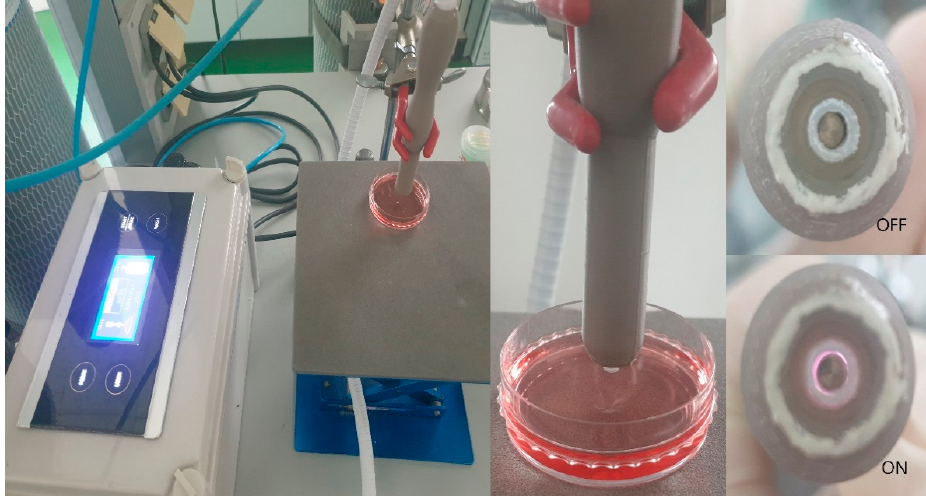
Figure 1. The figure of the NTP device used.